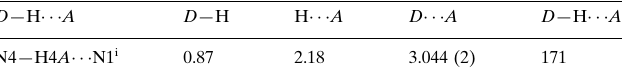
Hydrogen-bond geometry (A˚ , (cid:1)